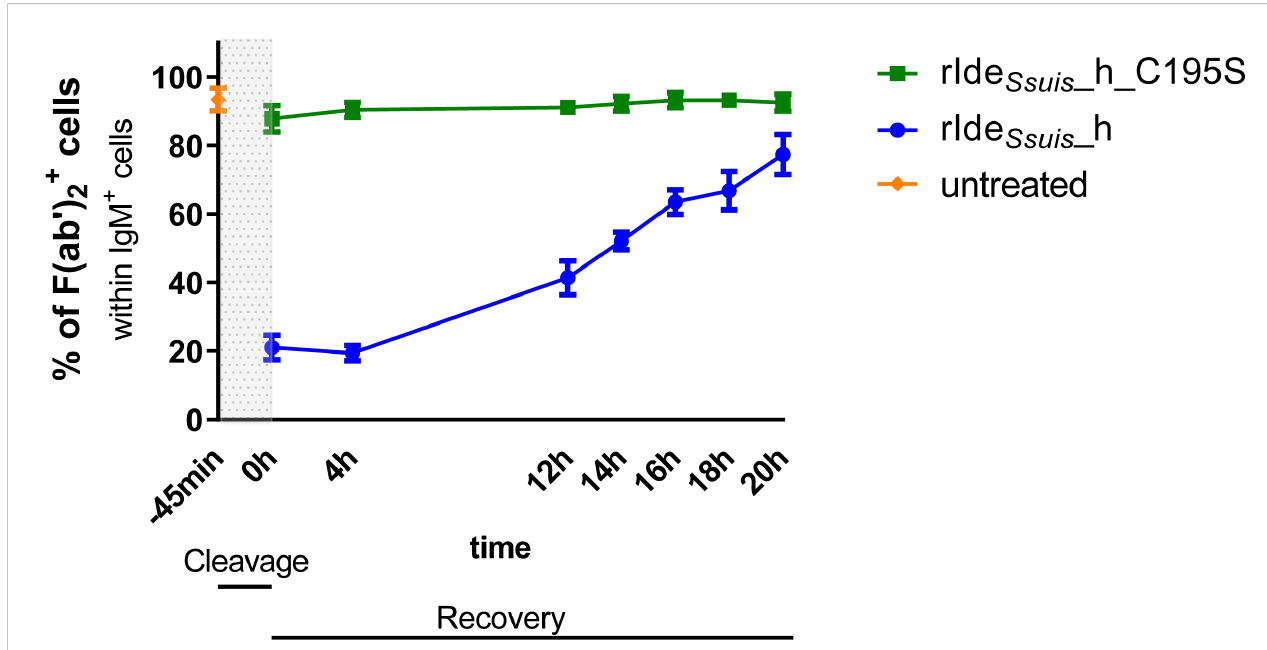
FIGURE 2 Recovery of IgM B cell receptor expression on porcine lymph node cells takes approximately 20 hours after rIde Ssuis _homologue mediated cleavage. Porcine mandibular lymph node cells of 11-month-old pigs (n = 5 for time points -45 min, 0 h, 4 h, 20 h; n = 3 for time points 12 h, 14 h, 16 h, 18 h) were incubated for 45 min with 4 µg/1x10 6 cells rIde Ssuis _homologue (rIde Ssuis _h) or non-functional rIde Ssuis _homologue_C195S (rIde Ssuis _h_C195S). After washing, cells were incubated for the given times in culture medium. Cells were stained and analyzed as described in Figure